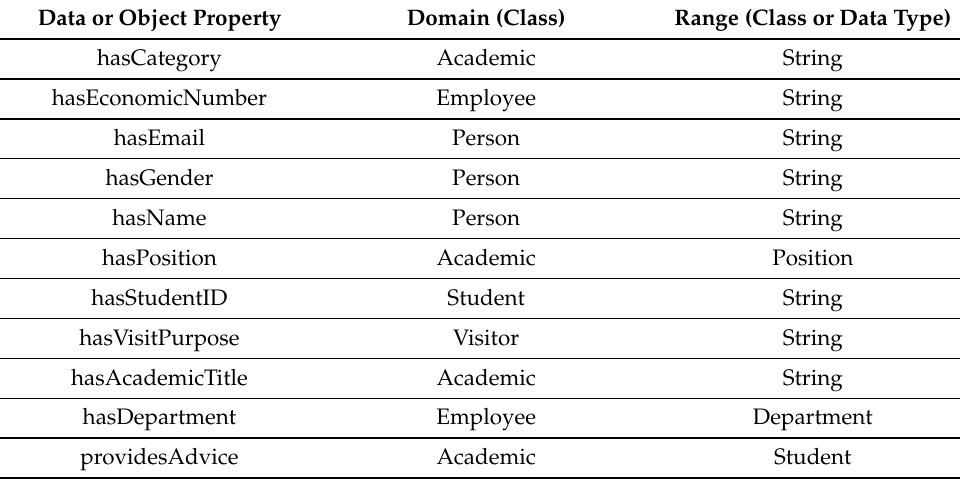
Figure 1. Class hierarchy of person ontology. Table 2. Data and object properties of the person